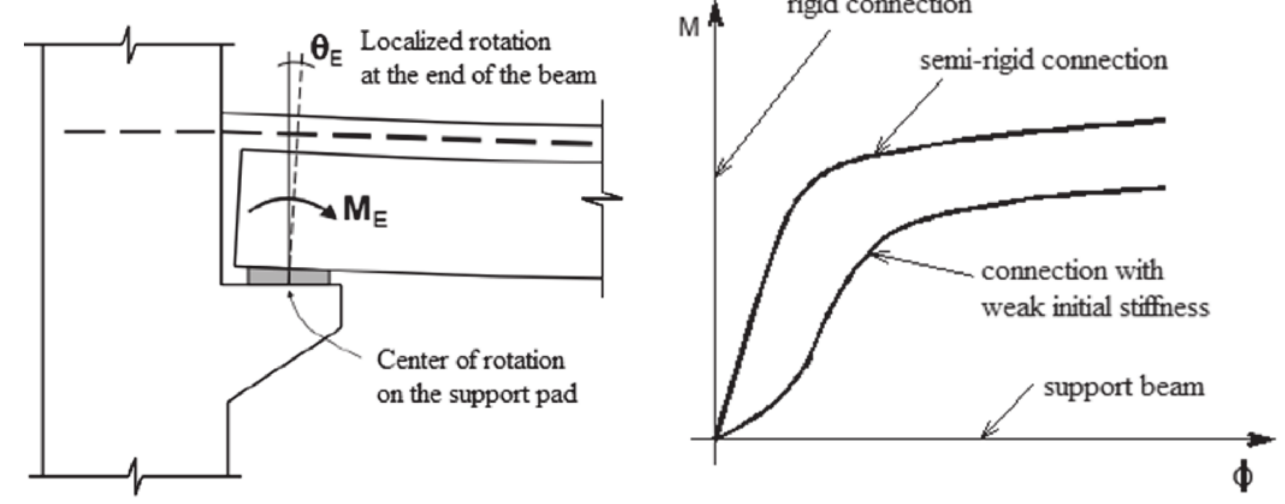
Moment vs. rotation curve of the connection, El Debs